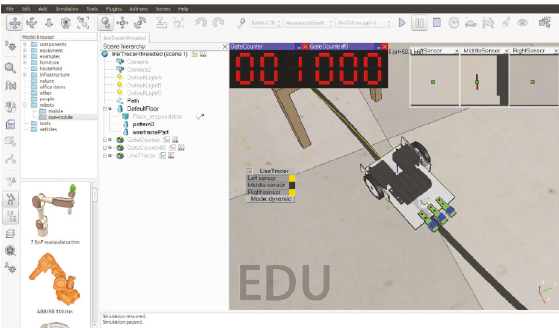
Figure 2: Data Collected from VRep Simulation.